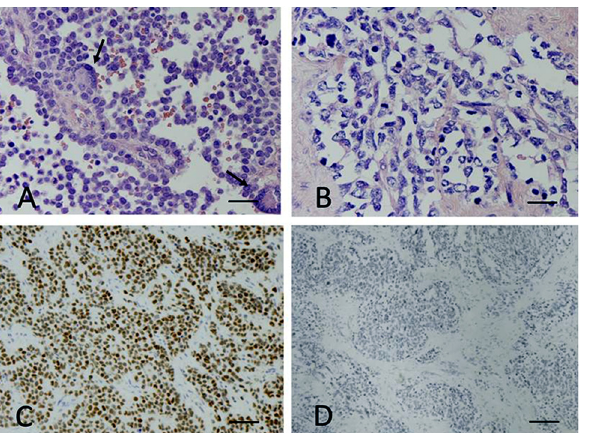
Fig 4. (A) Immunostaining for Ap2 β in HE section of a t+ ARMS showing the typical alveolar pattern and wreath-like cells (thin arrow) (320x, scale bar 60 μ m). (C) Immunostaining for Ap2 β in HE section of a t+ ARMS, showing a diffuse nuclear staining in more than 90% of cells, in keeping with the presence of translocation (160x, scale bar 120 μ m). (B) Mixed RMS; HE staining show an alveolar pattern, with polygonal cells lacking the monotony of an ARMS (320x scale bar 60 μ m). (D) Negative Ap2 β staining in HE section of the same mixed RMS confirming the lack of translocation (80x, scale bar 240 μ m).